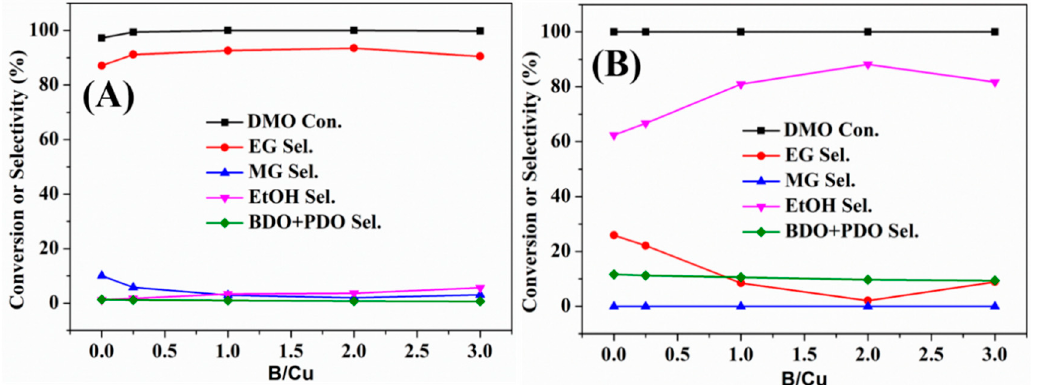
Figure 5. The correlation relationship between catalytic activity and B/Cu molar ratio of x B-Cu/SiO 2 catalysts. Reaction conditions: LHSV = 0.2 h − 1 , P = 2.0 MPa, H 2 /DMO molar ratio = 50. ( A ) 200 °C and ( B ) 260 °C.